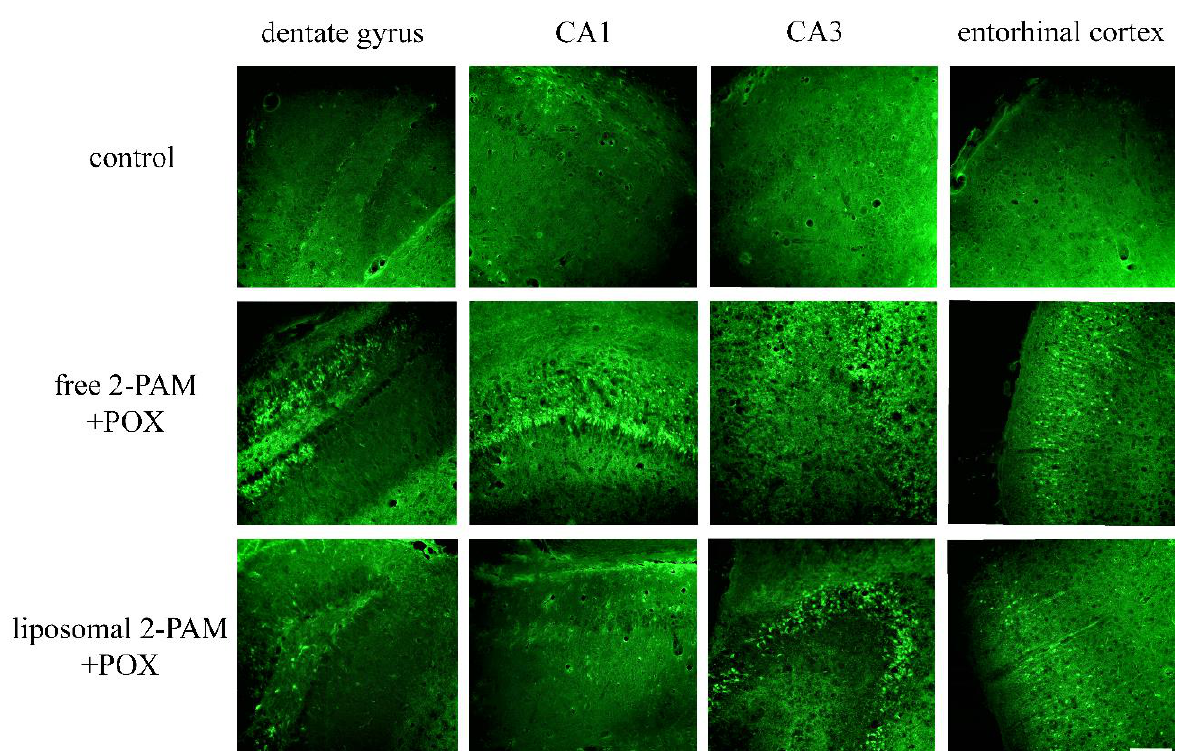
Figure 10. Representative microphotographs of Fluoro-Jade B staining showing the neuroprotective effect of liposomes loaded with 2-PAM following POX poisoning in the dentate gyrus, CA1, and CA3 areas of the hippocampus and in the entorhinal cortex of mice. Scale bar 100 μm . Table 6. Quantitative analyses of Fluoro-Jade B labeling in the dentate gyrus, the CA1 and CA3 zones of the hippocampus, and in the entorhinal cortex of mice poisoned by POX and treated with free 2-PAM or liposomal 2-PAM.